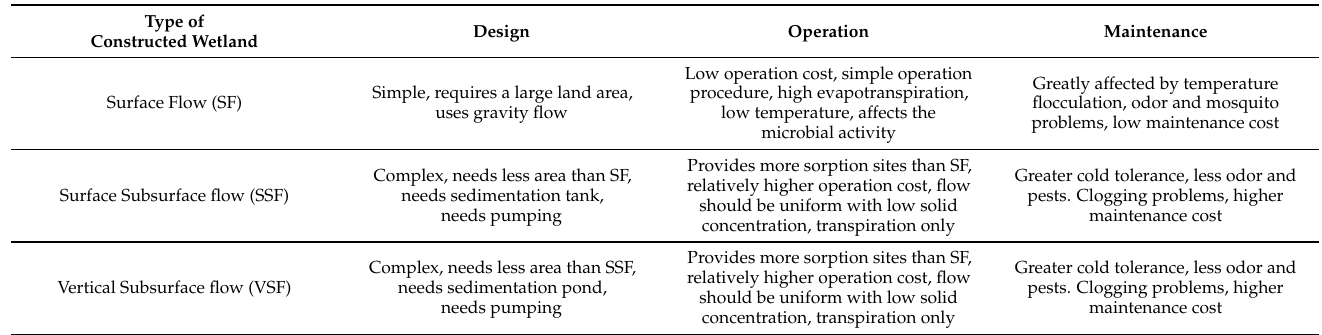
Table 1. Design, operation, and maintenance of